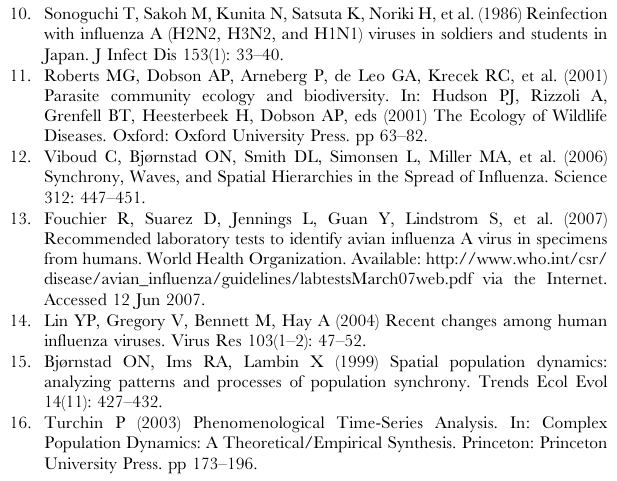
Movie S2 Movie showing time series of incidence data for H1. Maps show the natural log of adjusted weekly incidence data for H1. White indicates no data for a given week, and blue indicates a value of zero. The number of isolates increases on a log color scale, with purple indicating the maximum value for a given subtype. Plots below the map show the hemisphere weekly totals (blue = - Southern Hemisphere, and red = Northern Hemisphere) and are given as a reference point for time as the movie progresses. Found at: doi:10.1371/journal.pone.0001296.s002 (1.57 MB MOV) Movie S3 Movie showing time series of incidence data for B. Maps show the natural log of weekly incidence data for B. White indicates no data for a given week, and blue indicates a value of zero. The number of isolates increases on a log color scale, with purple indicating the maximum value for a given subtype. Plots below the map show the hemisphere weekly totals (blue = - Southern Hemisphere, and red = Northern Hemisphere) and are given as a reference point for time as the movie progresses. Found at: doi:10.1371/journal.pone.0001296.s003 (1.87 MB MOV) Figure S1 Mean annual incidence for each subtype. The percent of the total annual incidence belonging to a particular type or subtype for each season in each country was plotted on a color scale for (i) H3, (ii) H1, and (iii) B. Found at: doi:10.1371/journal.pone.0001296.s004 (9.54 MB